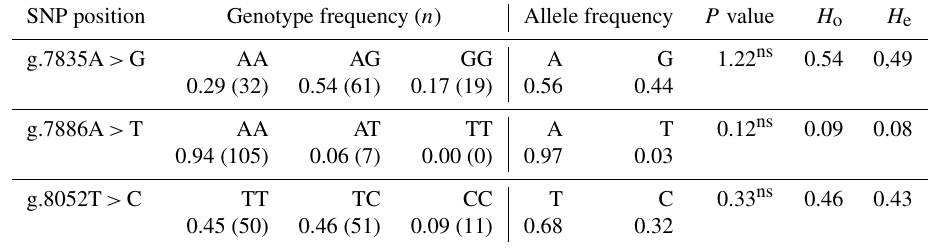
Table 1. Genotype frequency, allele frequency, heterozygosity and chi-squared test ( χ 2 ) prolactin gene SNPs (PRL) in IPB-D1 chickens. SNP position Genotype frequency ( n ) Allele frequency P value H o